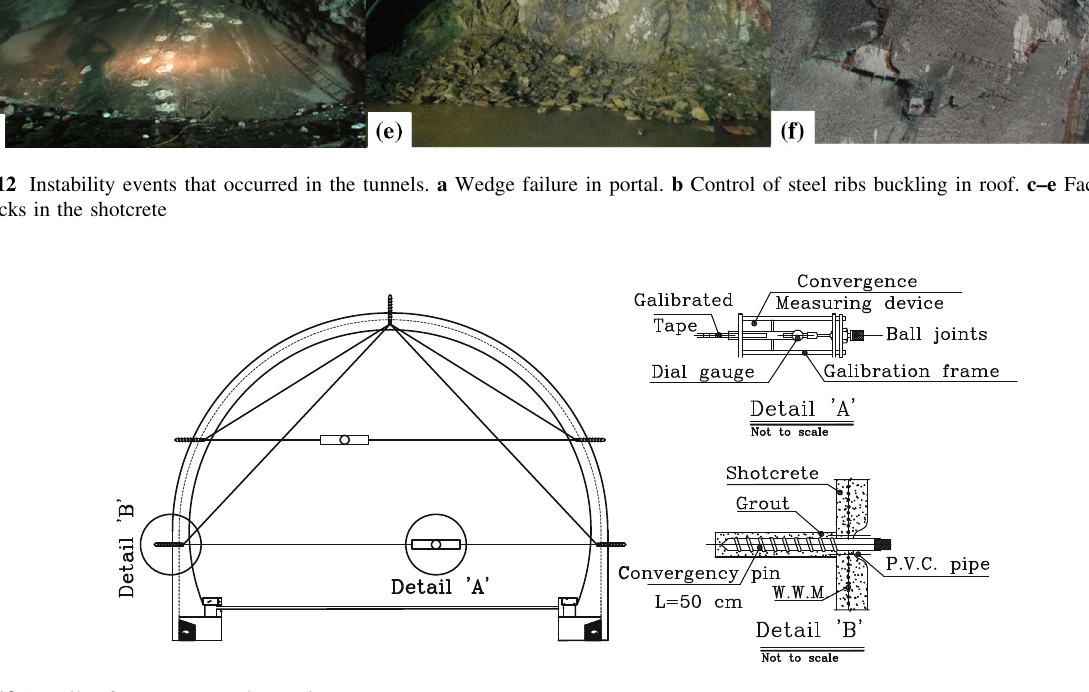
Fig. 13 Details of convergence pins